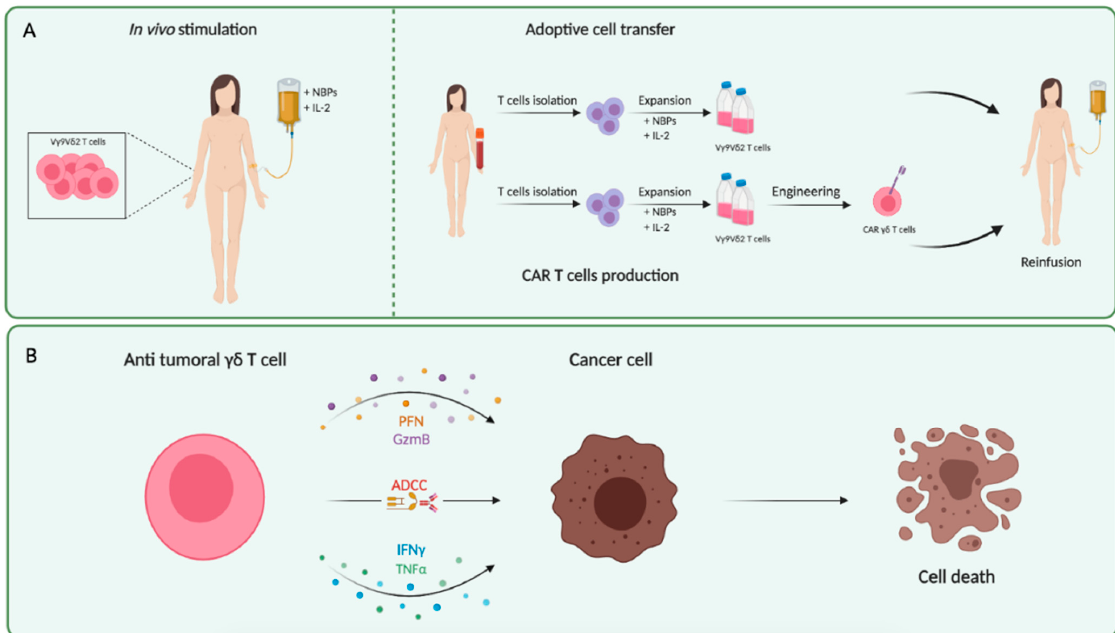
Figure 2. γδ T cells: clinical use and antitumor activity. ( A ) Clinical trials based on γδ T cells rely on the V γ 9V δ 2 subset, taking advantage of two distinct approaches, in vivo and ex vivo. In vivo stimulation involves N-BPs administration, in combination with IL-2, necessary for V γ 9V δ 2 expansion. Adoptive cell transfer (ex vivo approach) requires isolating T cells from PBMCs and V γ 9V δ 2 activation by culture with N-BPs plus IL-2. Then, the expanded V γ 9V δ 2 cells are reinfused into patients. Furthermore, to perform CAR-T cell production, V γ 9V δ 2 are expanded as previously and transduced with the specific CAR retrovirus. ( B ) The cytotoxic mechanisms exerted by γδ T cells, triggered upon TCR-dependent antigen recognition, mainly include perforin–granzyme pathway, ADCC, IFN- γ and TNF- α production. Abbreviations: N-BPs, nitrogen-containing bisphosphonates; IL-2, interleukine-2; PBMCs, peripheral blood mononuclear cells; CAR, chimeric antigen receptor; TCR, T cell receptor; ADCC, antibody-dependent cell-mediated cytotoxicity. Table 1. Characteristics that make γδ T cells good defenders against tumors compared to others T cells. Features γδ T Cells Other T Cells High